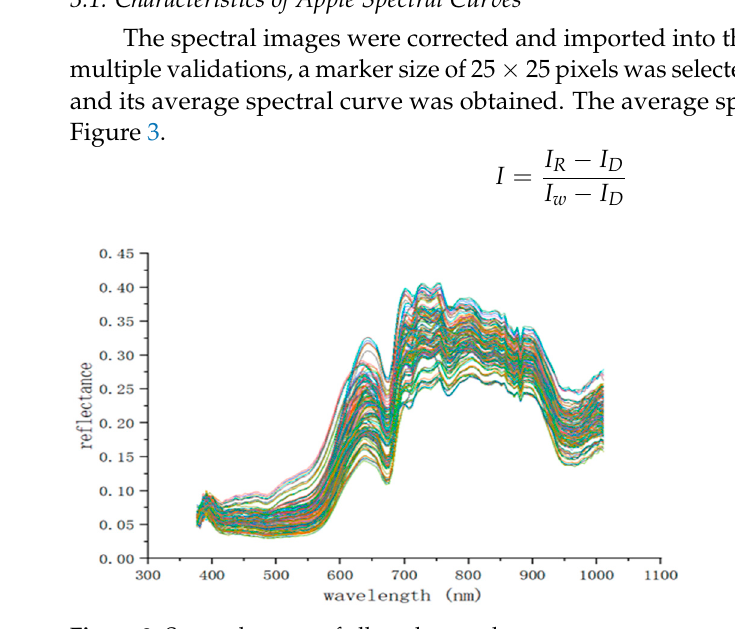
Figure 3. Spectral curves of all apple samples.